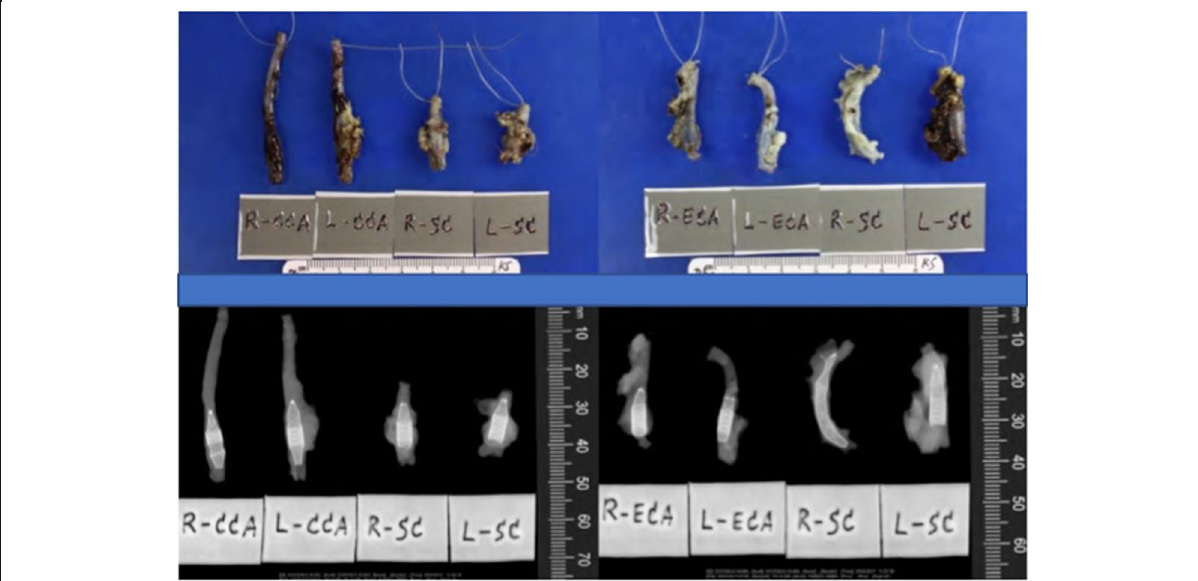
Fig. 6 Macroscopic and radiographic analysis of the explanted vessel segments of subjects number 1 and